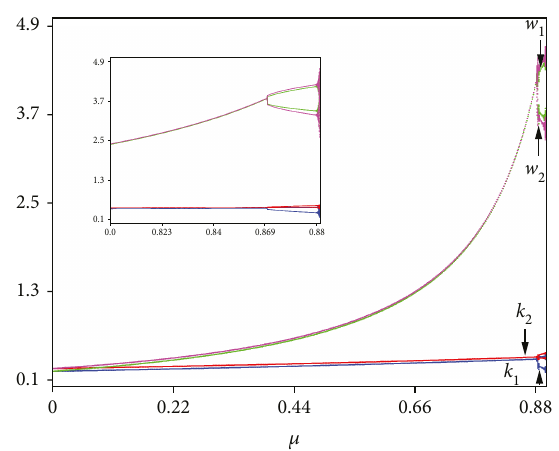
Figure 16: Bifurcation diagram of k μ ∈ 0, 0 89 1 , k 2 , w 1 , w 2 when